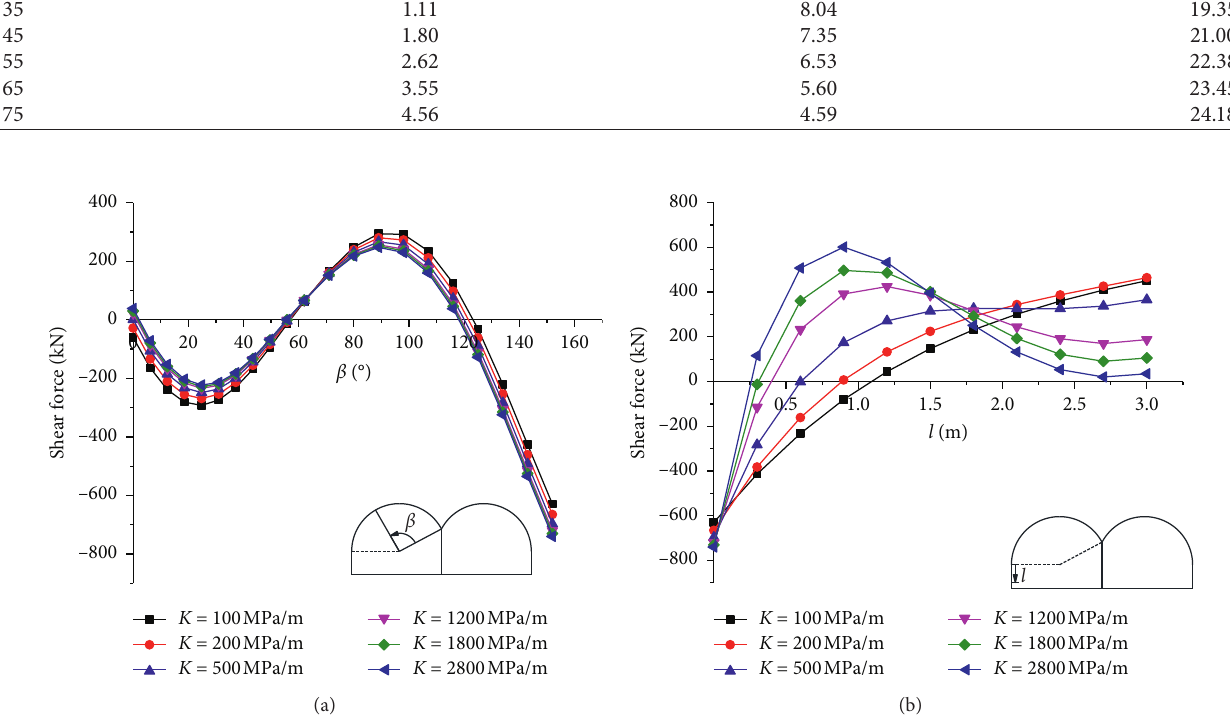
Figure 17: Variations of shear force with ( K ): (a) along the arch ring; (b) along the side wall.